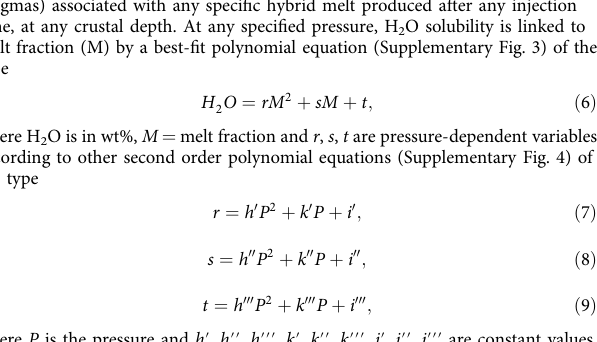
abbreviations: K = Cu/Au moral ratio of alkaline rocks; CA = Cu/Au moral ratio of calc-alkaline rocks; PF = Cu/Au moral ratio of single-phase porphyry fl uids; VE = Cu/Au moral ratio of volcanic emissions (Table